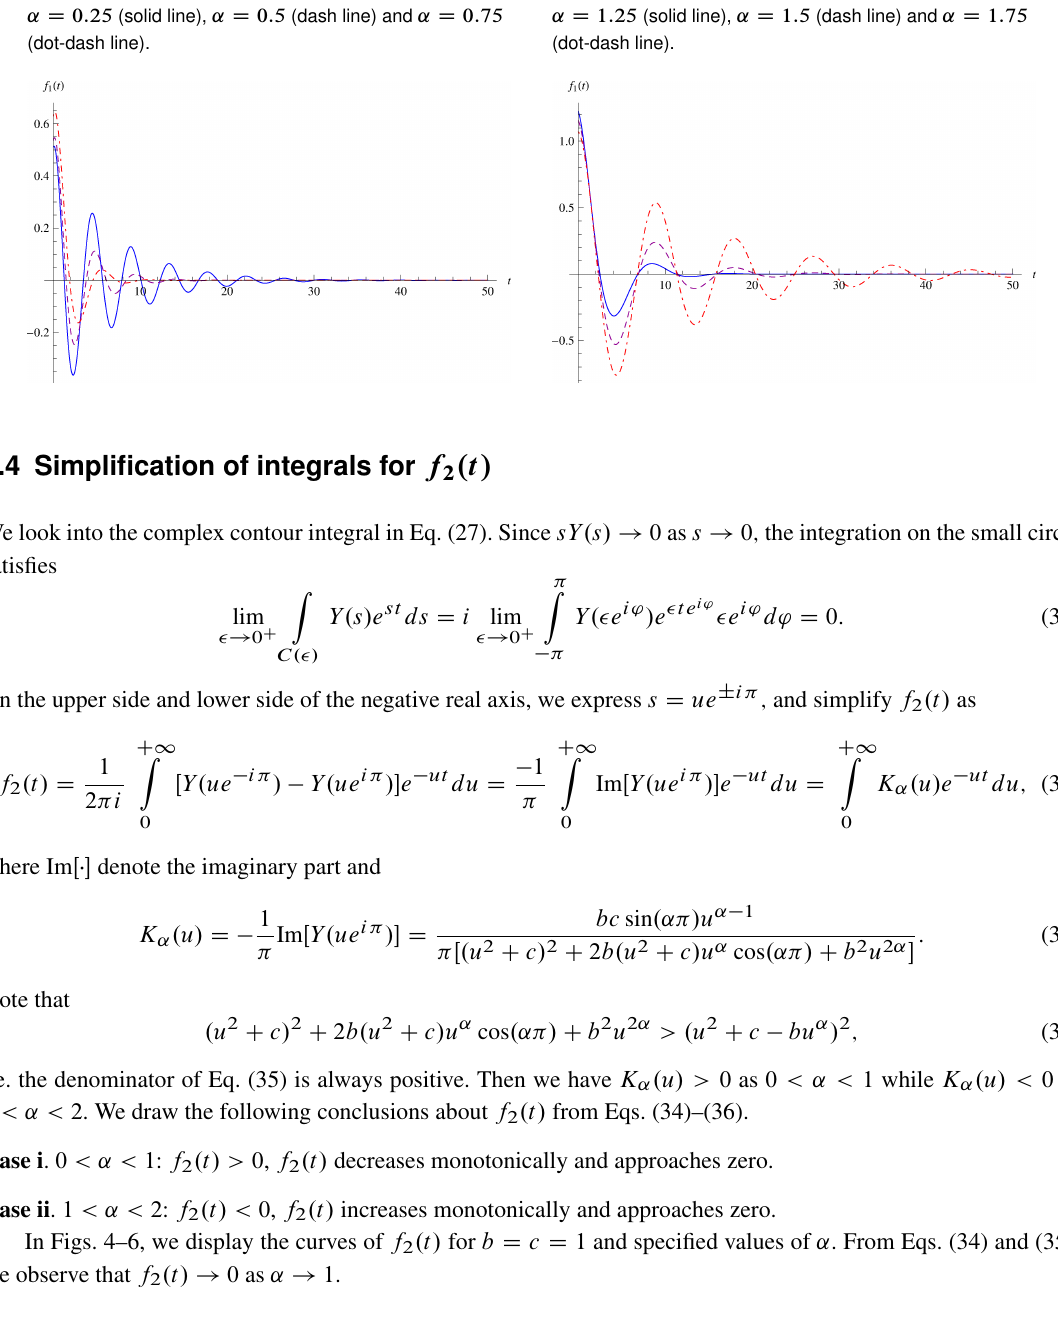
Fig. 2. The curves of f 1 .t/ for b D c D 1 and for ˛ D 0:25 (solid line), ˛ D 0:5 (dash line) and ˛ D 0:75 (dot-dash line).